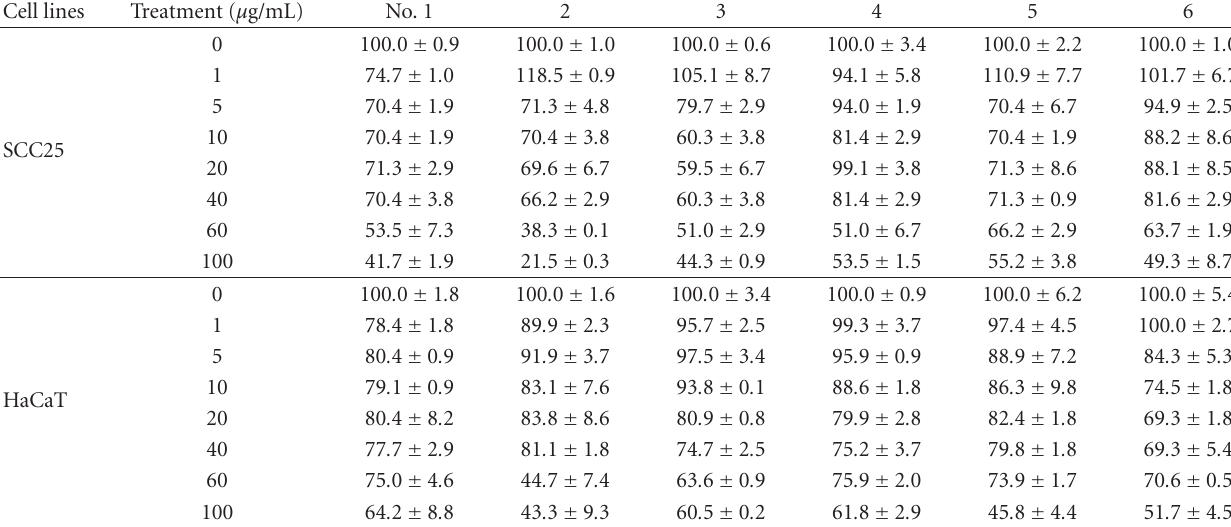
Table 1: Percentage of SCC25 and HaCaT cells adhesion by di ff erent concentrations of the genus Sinularia extracts. Cell